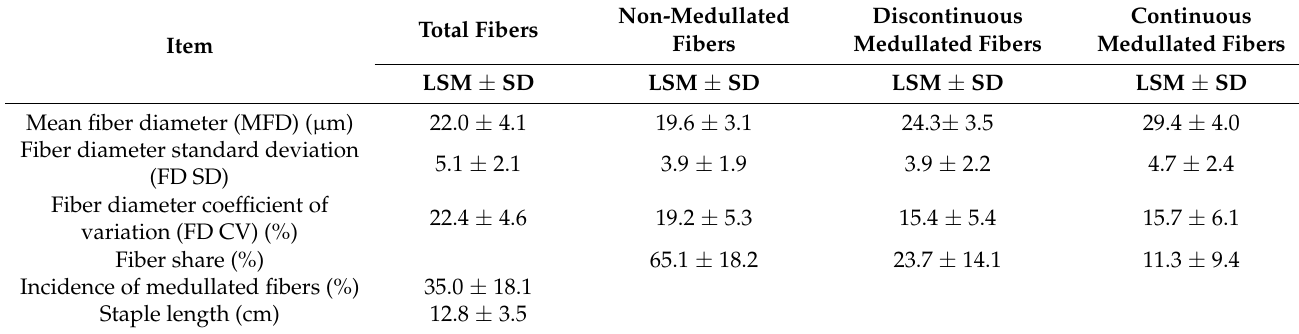
Table 1. The overall characteristics of wool quality for the alpacas being investigated.